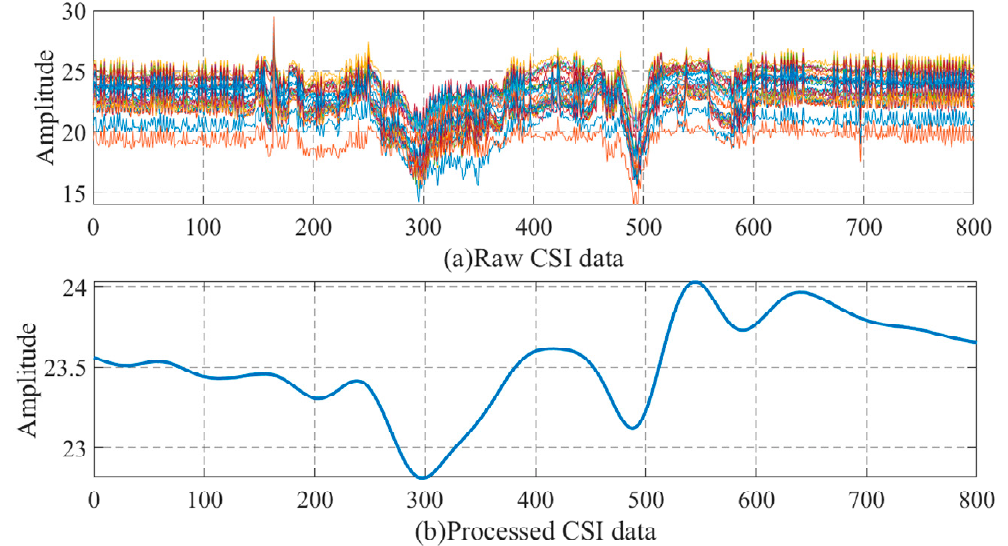
Figure 2. Schematic diagram of CSI data preprocessing. ( a ) Raw CSI data, ( b ) Processed CSI data.